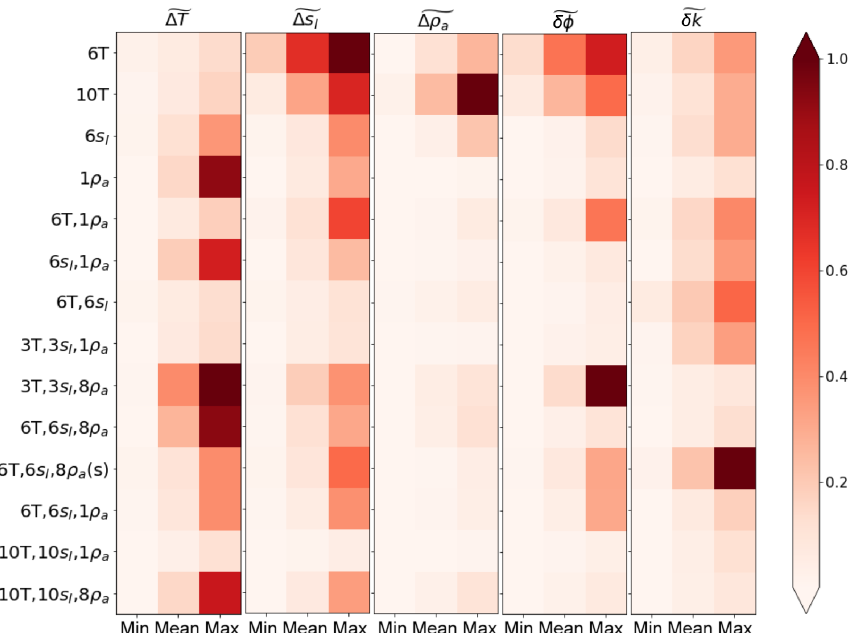
Figure 7. Five matrix tables presenting fitness metrics between synthetic model values and values obtained by the parameter estimation method using meteorological data from the year 2015 from the BEO site in Alaska. Matrix tables from left to right correspond to the nor- malized root-mean-squared errors for temperatures, liquid water saturations, and apparent resistivities as well as to the normalized Euclidian distances between synthetic (true) and estimated values of porosities and thermal conductivities. Each matrix value was normalized by dividing it by the matrix maximum value. The normalized values are indicated by